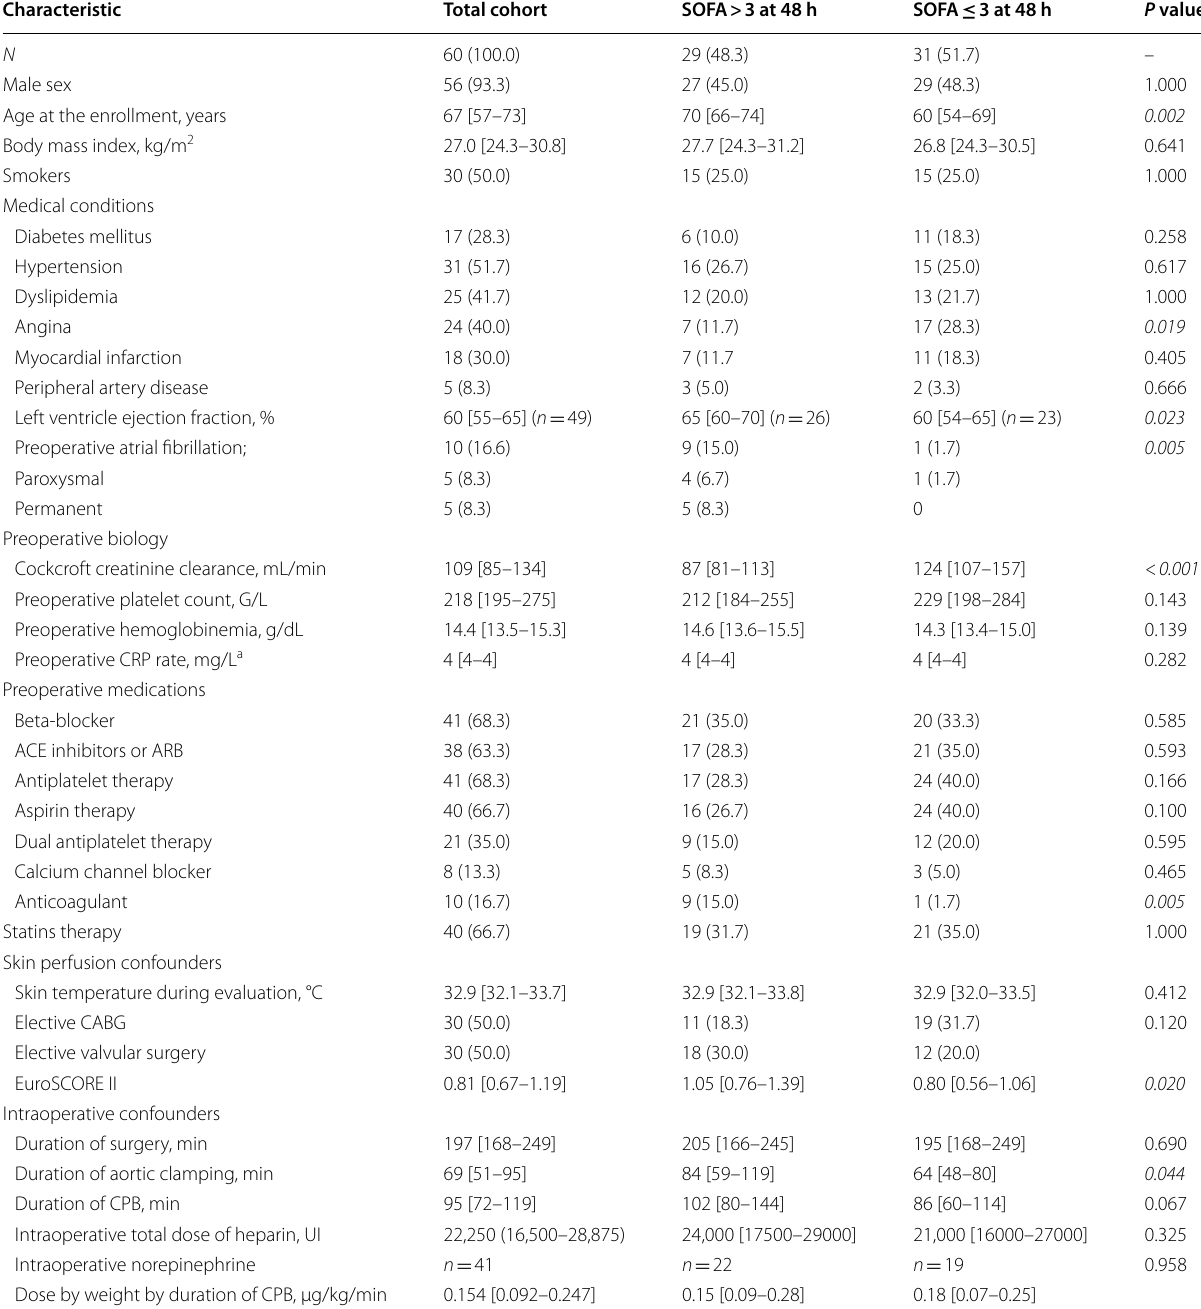
Table 1 Characteristics of